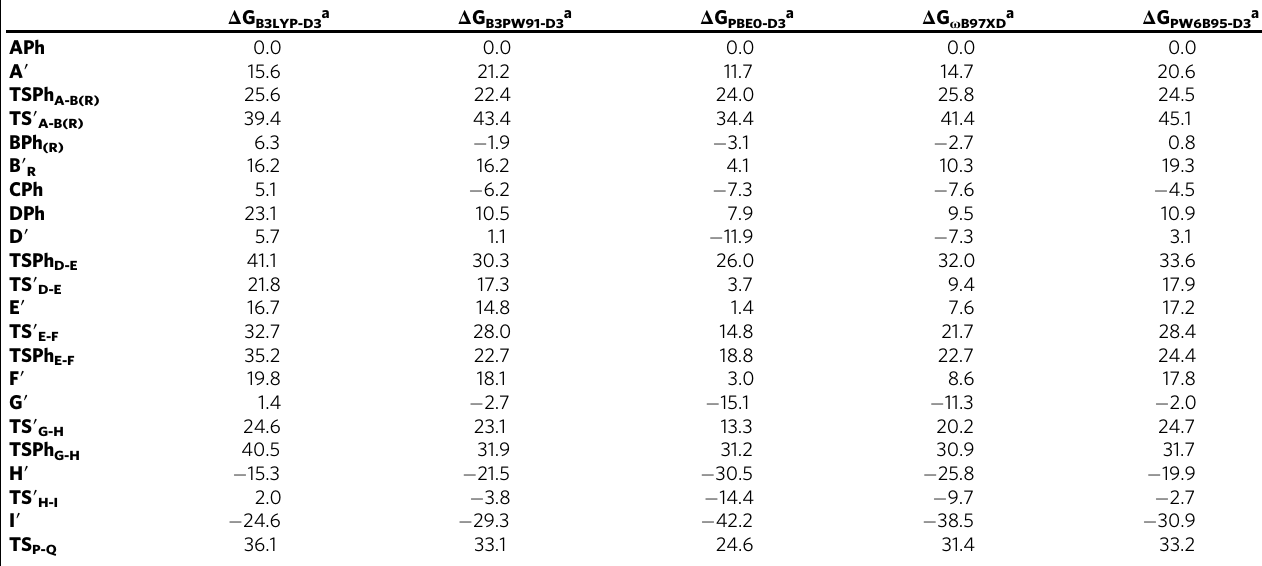
Table 4 The relative free energies (in kcal/mol) of the most possible pathway (i-Ph) and the barrier for the lowest-energy side- reaction oxidative coupling pathway (via TS P-Q ) for the Rh(I)-catalyzed cycloisomerization of a 1,6-allenyne (1a) in solution phase by different DFT methods (except PW6B95-D3 in gas phase). PPh 3 was used as the additional